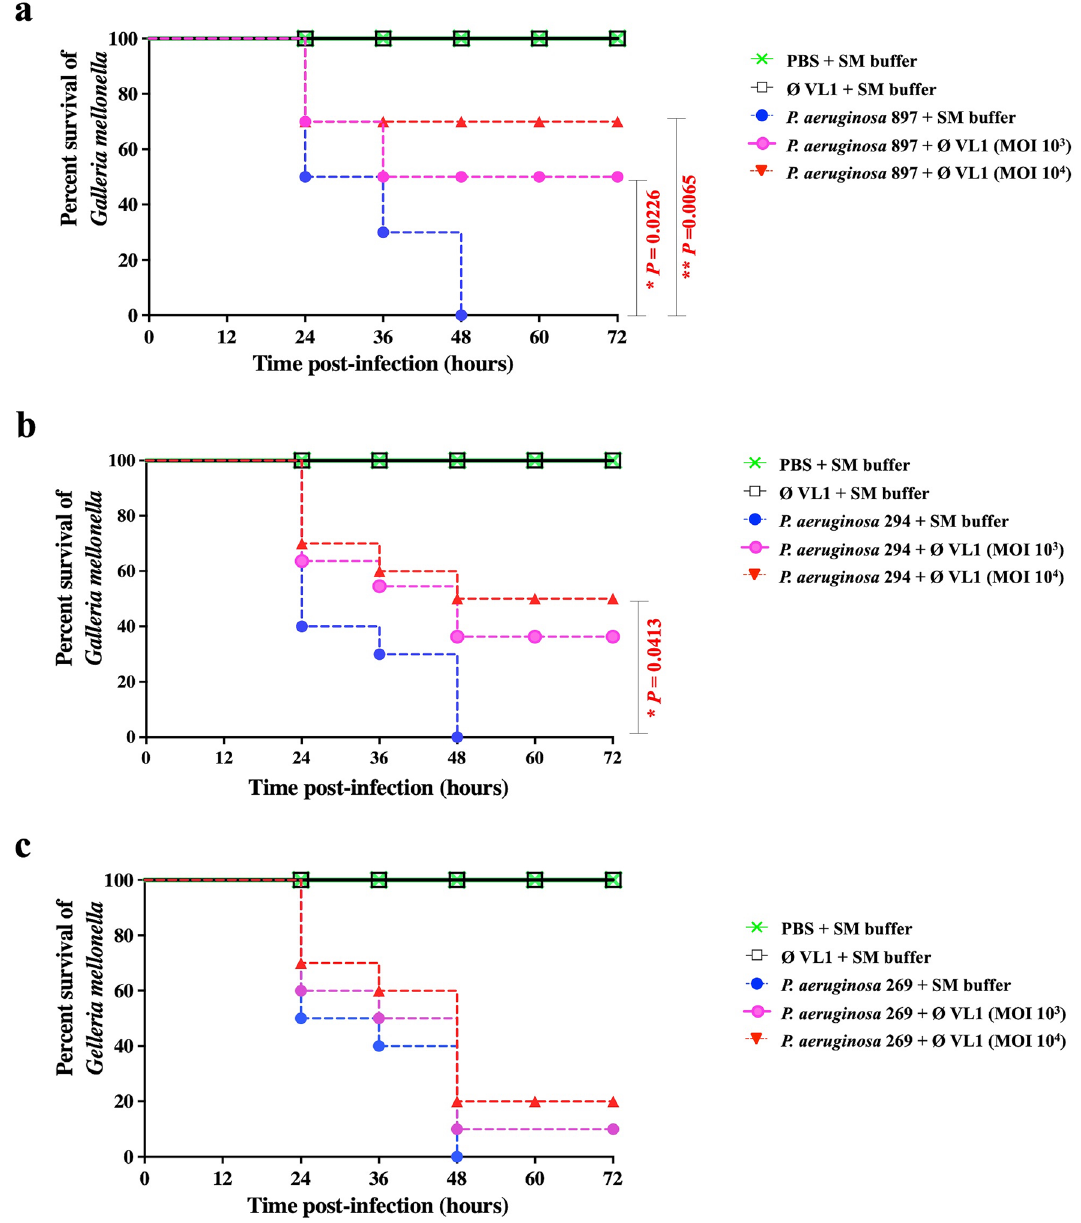
Figure 7. Percent survival of MDR P. aeruginosa infected G. mellonella larvae after phage vB_PaeS_VL1 treatment. Groups of 10 larvae were inoculated with either MDR P. aeruginosa strains ( a ) PA897, ( b ) PA294 or ( c ) PA269 follow by treatment with phage VL1 at MOI of 1,000 or 10,000 at 1 h p.i.. The numbers of dead larvae were determined every 12 h for 72 h p.i. GraphPad Prism software was used to graph and analyze the data using a Log-rank (Mantel-Cox) test. Asterisks indicated significant differences (* P < 0.05 or ** P < 0.01) between bacterial infection groups, and the phage treatment groups. Data is representative of that obtained in three independent experiments (n = 3 biological